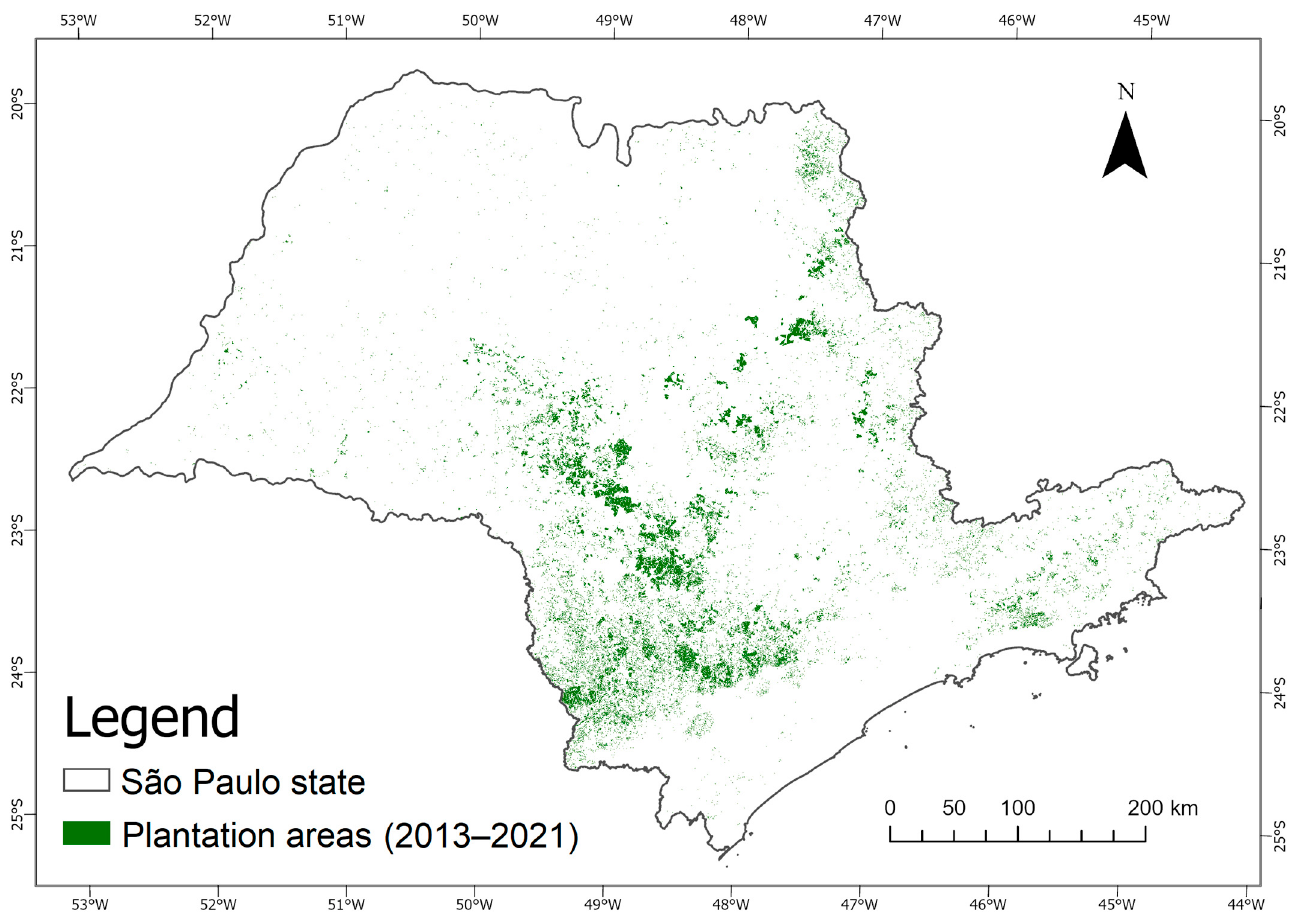
Figure 6. Classification of plantation areas in the study area during the study period (2013–2021), based on the Landsat OLI annual mosaics.